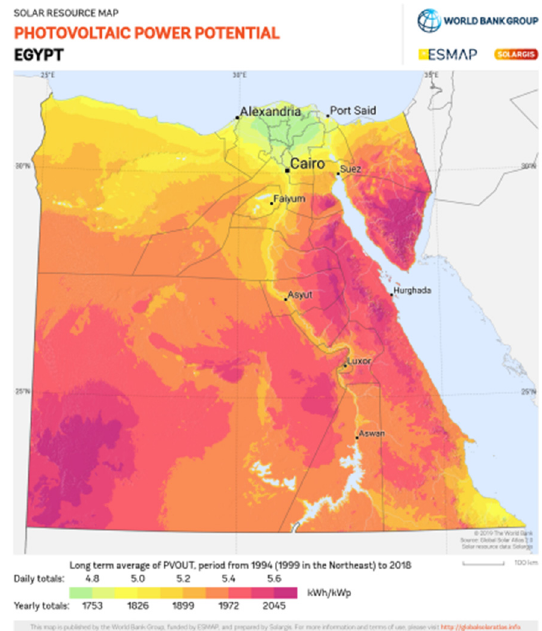
Figure 1. Specific solar energy output of Egypt, Reproduced from [20]., World Bank Group: 2018. Egypt is within the lower half of the legend range. According to this figure Zagazig has a mean wind power density slightly below 200 W / m 2 (See Figure 2). This may imply a lesser wind focus when supplying electricity in Zagazig.